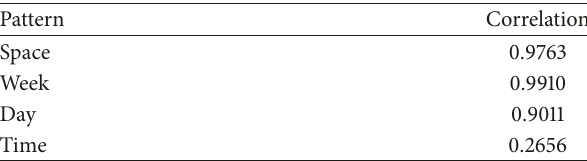
Table 2: The relevance of each